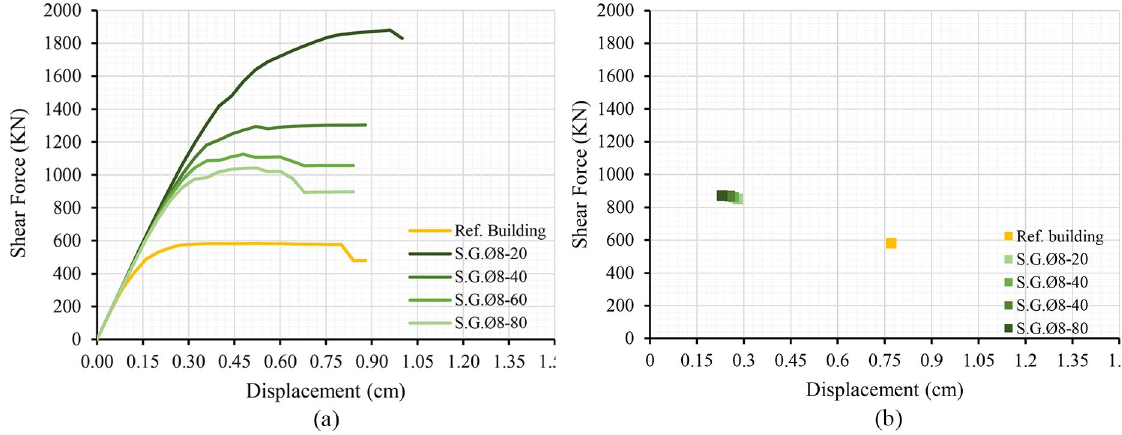
Fig 7. Capacity curves (a) and performance points (b) of the models adding steel grids varying the bar